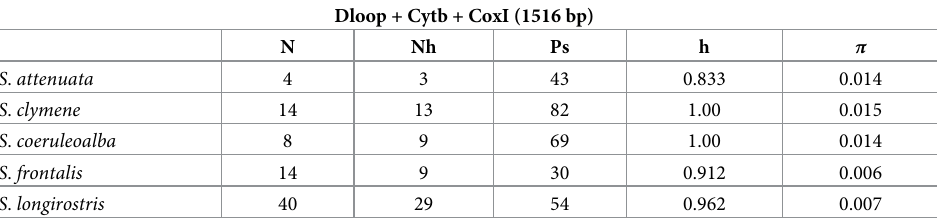
Table 1. Genetic diversity values of the five Stenella species from Brazilian waters for 1516 base pairs (bp) of mtDNA (Dloop + Cytb + CoxI). Sample size (N), number of haplotypes (Nh), polymorphic sites (PS), haplotype diversity (h), and nucleotide diversity ( π ).